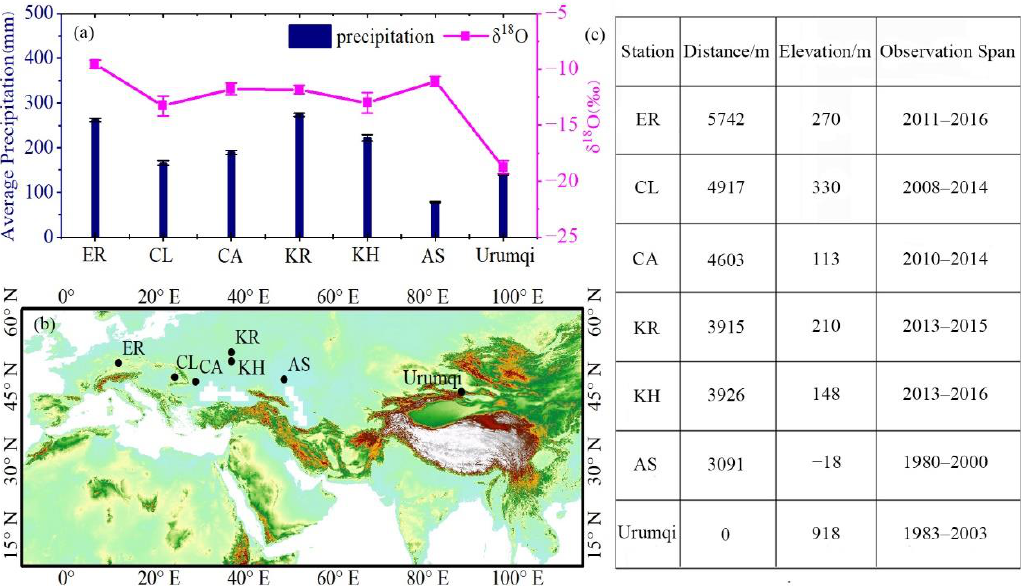
Figure 9. Scatter plot of precipitation versus total q (g/kg) in all water vapor source regions. Water vapor in WE, NP and SB were significantly positively correlated with Northern Xinjiang precipitation (Figure 10). A Pearson correlation analysis was conducted between the precipitation and accumulated q of air trajectory in 6 water vapor source regions. The slope of WE was 0.2628, which was clearly larger than that for NP and SB. The correlation coefficient R of WE, which was 0.66 (Figure 10a), was larger than that of SB (0.57; Figure 10b) and NP (0.45; Figure 10c). The correlation analysis results of the other three water vapor source regions, which were CEC, LA, and WA, did not pass the confidence test. Therefore, the water vapor from WE played a curial role in precipitation in Northern Xinjiang.